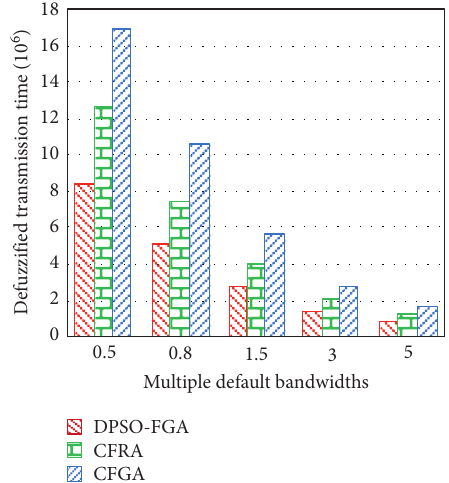
Figure 4: Average fuzzy data fuzzy transmission time of different algorithms with various bandwidths between data